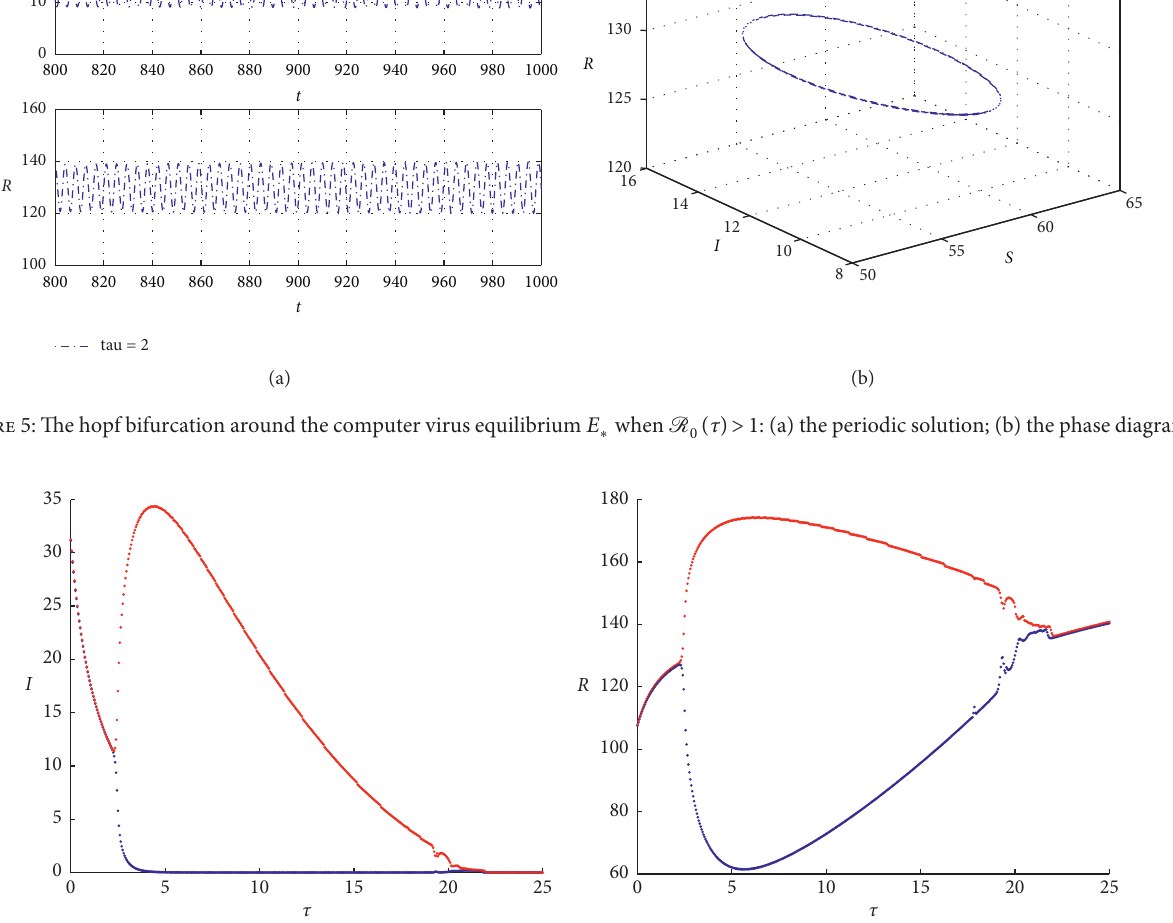
Figure 6: The dynamic behaviors of system (4) as the delay τ increases: (a) the virus-infected computers; (b) the recovery